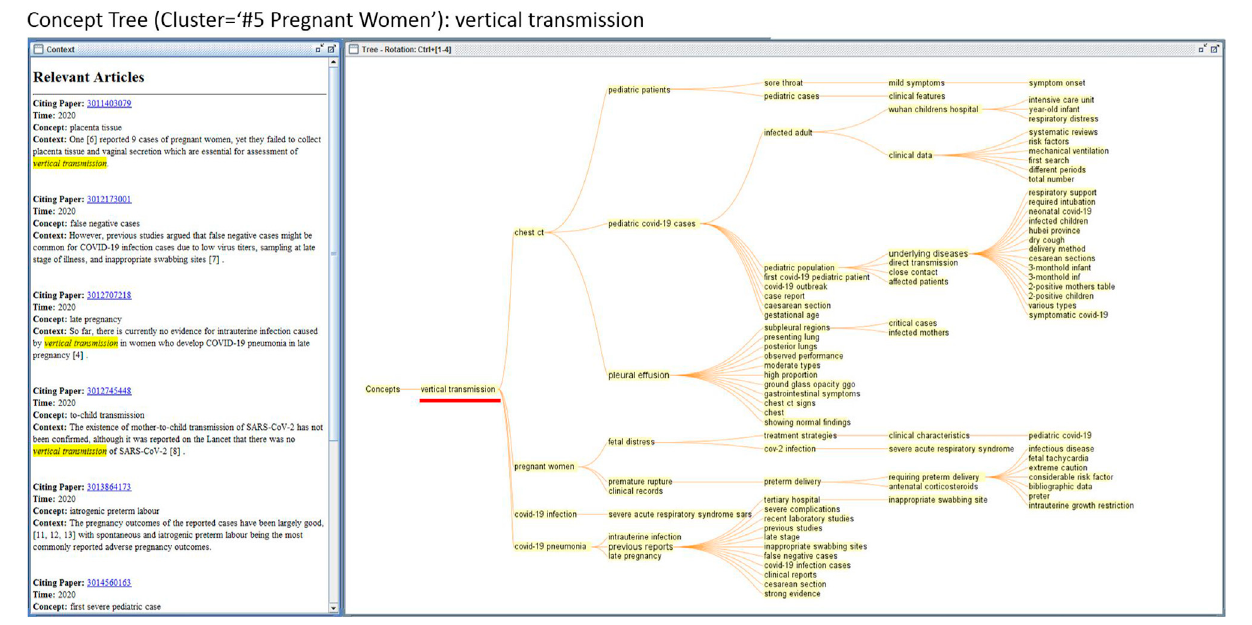
FIGURE2| Makingsenseofacluster (#5pregnant women).Thelist ofcitationcontexts shown intheleft window corresponds tothecurrent mouse-over event on the concept of vertical transmission.